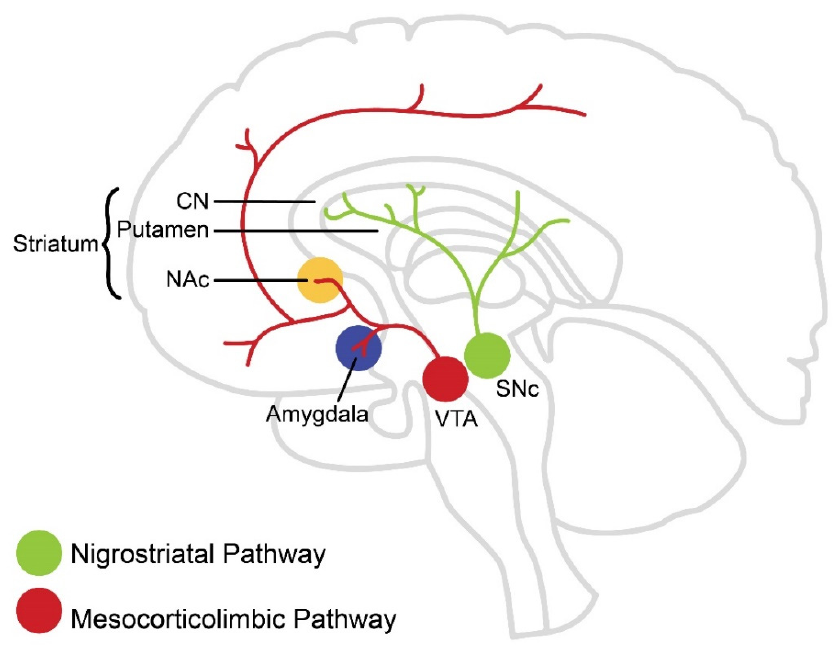
Figure 1. Dopamine Pathways. Dopaminergic neurons originating from the ventral tegmental area (VTA) project to the nucleus accumbens (NAc), amygdala, hippocampus, and prefrontal cortex (PFC) and are referred to as the mesocorticolimbic DA pathway. Dopaminergic neurons originating from the substantia nigra pars compacta (SNc) project primarily to the dorsal striatum and are referred to as the nigrostriatal DA pathway.